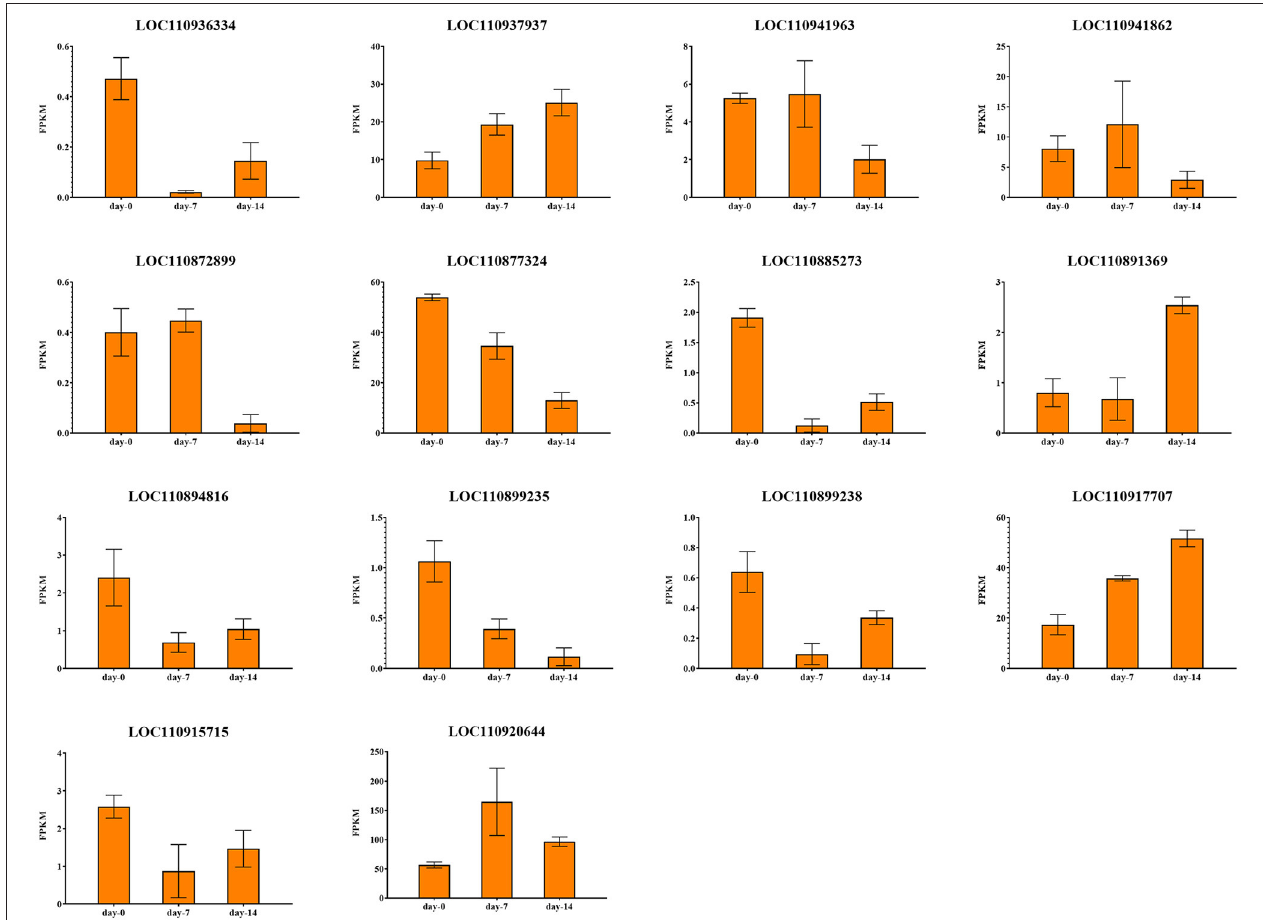
FIGURE 11 | Expression profiles of 14 drought response candidate